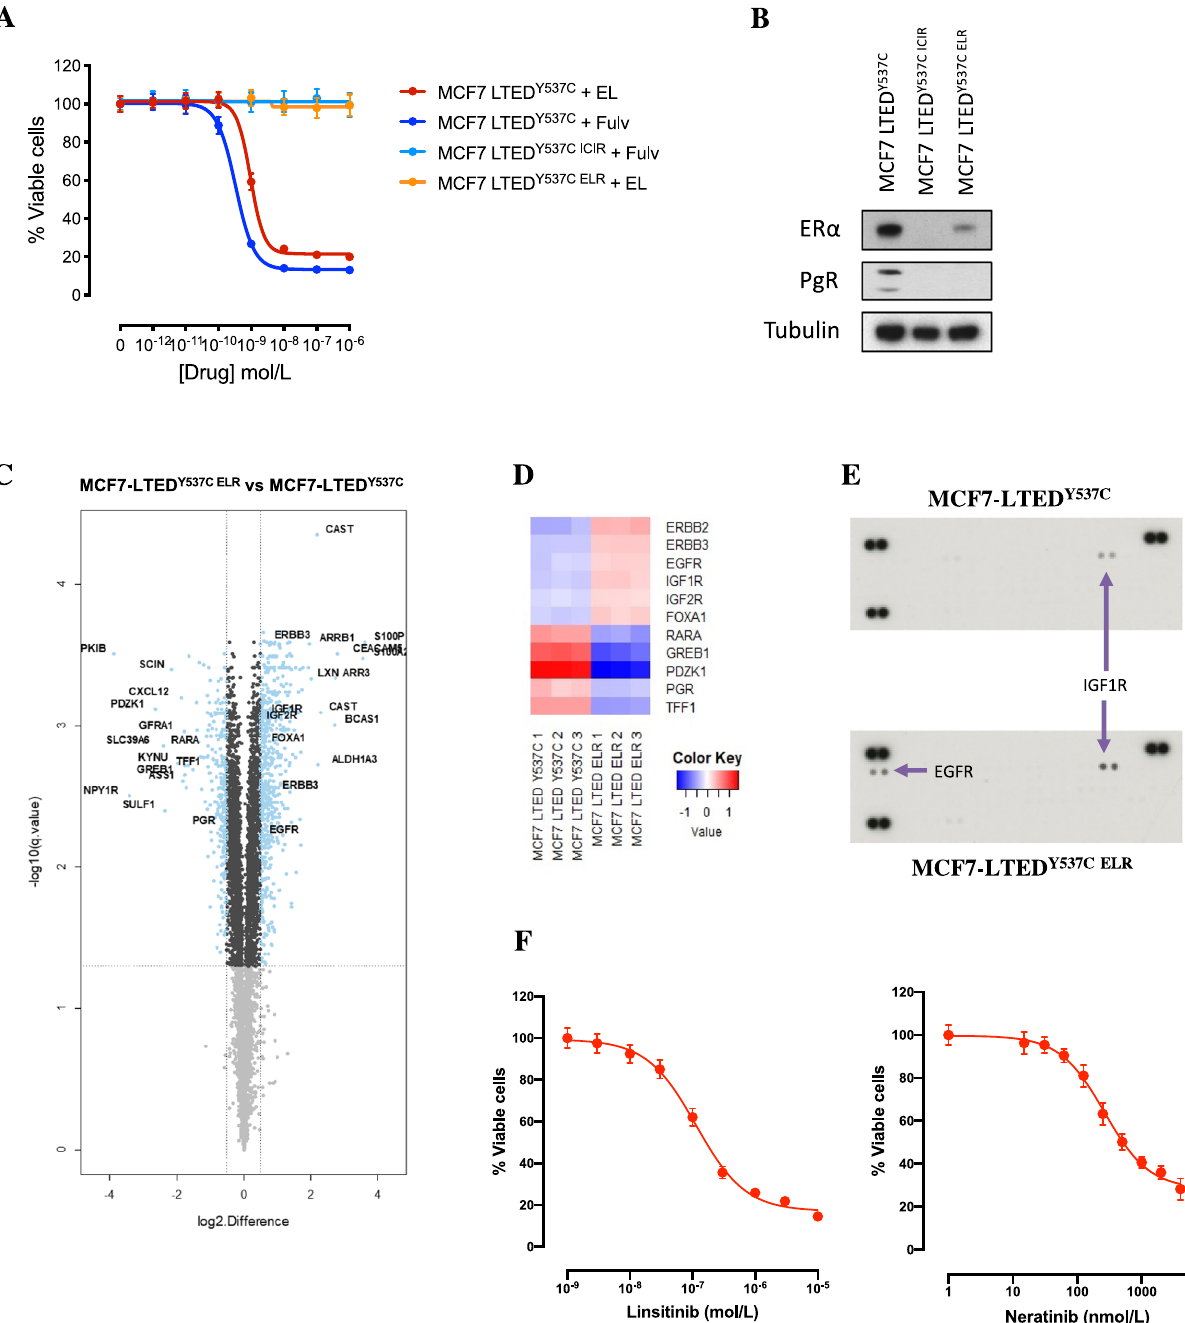
Fig. 7 Mechanisms of resistance to elacestrant. A Effect of escalating concentrations of fulvestrant and elacestrant on the proliferation of MCF7-LTED Y537C and its corresponding derivatives fulvestrant (ICIR) and elacestrant (ELR) resistant cell lines. Data represents % viable cells compared to vehicle control for each cell line. Error bars represent mean ± SEM ( n = 3 biological experiments with six technical replicates). B Immunoblotting showing ER and PGR abundance (data representative of n = 3 biological replicates). C Volcano plot showing signi fi cant up- and downregulated proteins (blue) in MCF7-LTED Y537C ELR cells in relation to the parental cell line (data generated from n = 3 biological replicates). Top signi fi cant proteins, E-regulated targets and growth factors are highlighted. D Heatmap representation of the protein expression of E-regulated targets, ER modulators and growth factors in MCF7-LTED Y537C parental versus MCF7-LTED Y537C ELR . E Reverse phase protein arrays assessing receptor tyrosine kinase expression. F Effect of escalating concentrations of linsitinib and neratinib on the proliferation of MCF7-LTED Y537C ELR cell lines. Data represents % viable cells compared to vehicle control for each cell line. Error bars represent mean ±